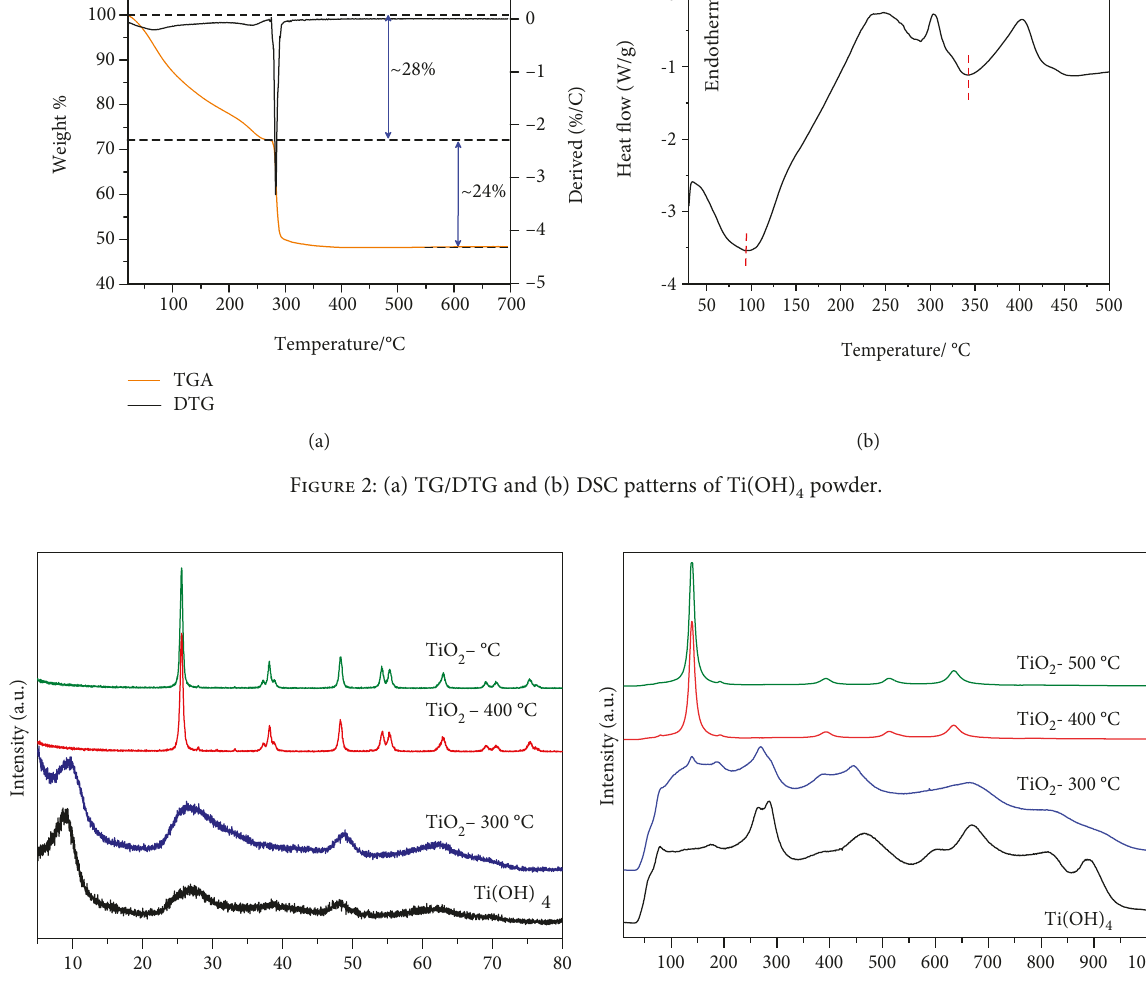
, TiO -300 ° C, TiO -400 ° C, and TiO 4 2 2